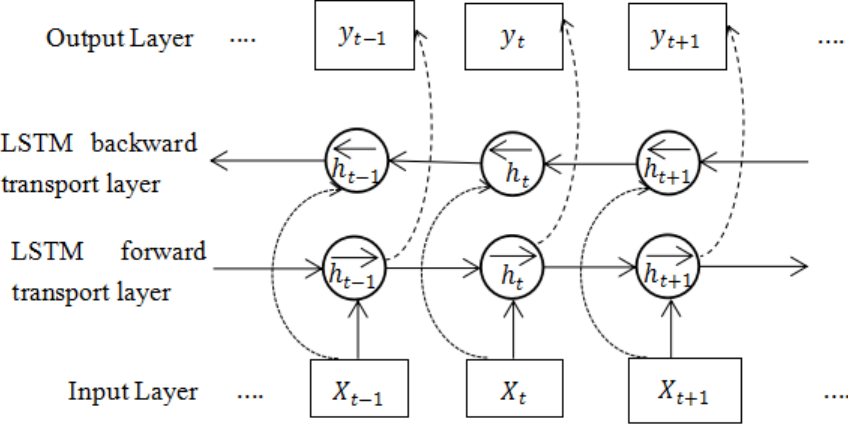
Figure 3. BiLSTM structure diagram.